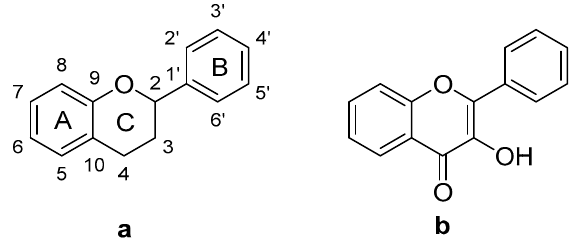
Figure 1. ( a ) Base structure of flavonoids; ( b ) Structure of flavonols.